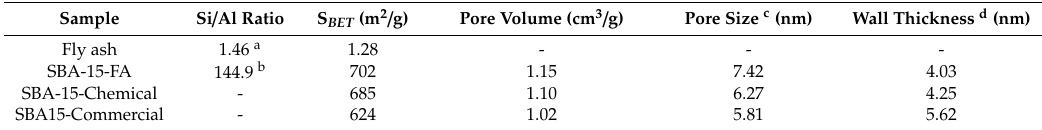
Table 2. Physical and textural properties of the raw material and synthesized SBA-15 catalysts.